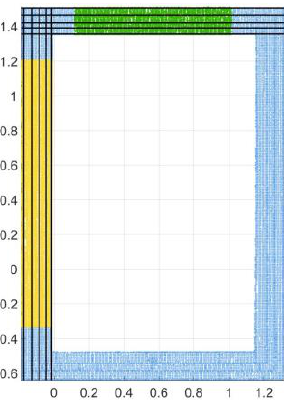
Figure 8. Axes detected after PCA computation on left part (yellow) and upper part (green) of the window frame The mean axes of each part are projected on a same plane (the mean plane of the frame) and used to compute successive axes intersections. This enables to rebuild the 4 frame corners. For a door jamb, the lower corners are determined as the intersections of left and right axes with a plane modeling the ground.